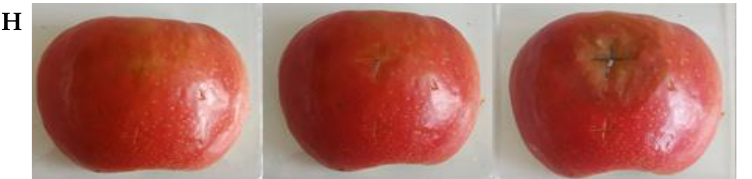
Figure 2. Images of apples obtained during their storage: ( A ) — noncontaminated apples (control sample); ( B ) — apples contaminated with Botrytis cinerea mold spores; ( C ) — apples contaminated with Penicillium expansum mold spores; ( D ) — apples contaminated with a mixture of B. cinerea and P. expansum mold spores; ( E ) — apples contaminated with Rhizopus stolonifer mold spores; ( F ) — apples contaminated with a mixture of R. stolonifer and B. cinerea mold spores; ( G ) — apples contaminated with a mixture of R. stolonifer and P. expansum mold spores; ( H ) — apples contaminated with a mixture of R. stolonifer , B. cinerea , and P. expansum mold spores. Figure 3 presents the temperature changes recorded with a VIGOcam V60 camera during 48 h incubation of apples.